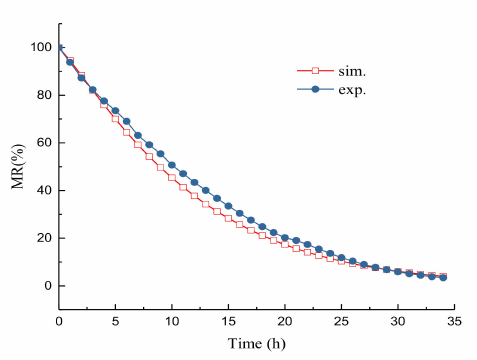
Figure 8. Comparison of experimental moisture ratio with the predicted moisture ratio from the Page